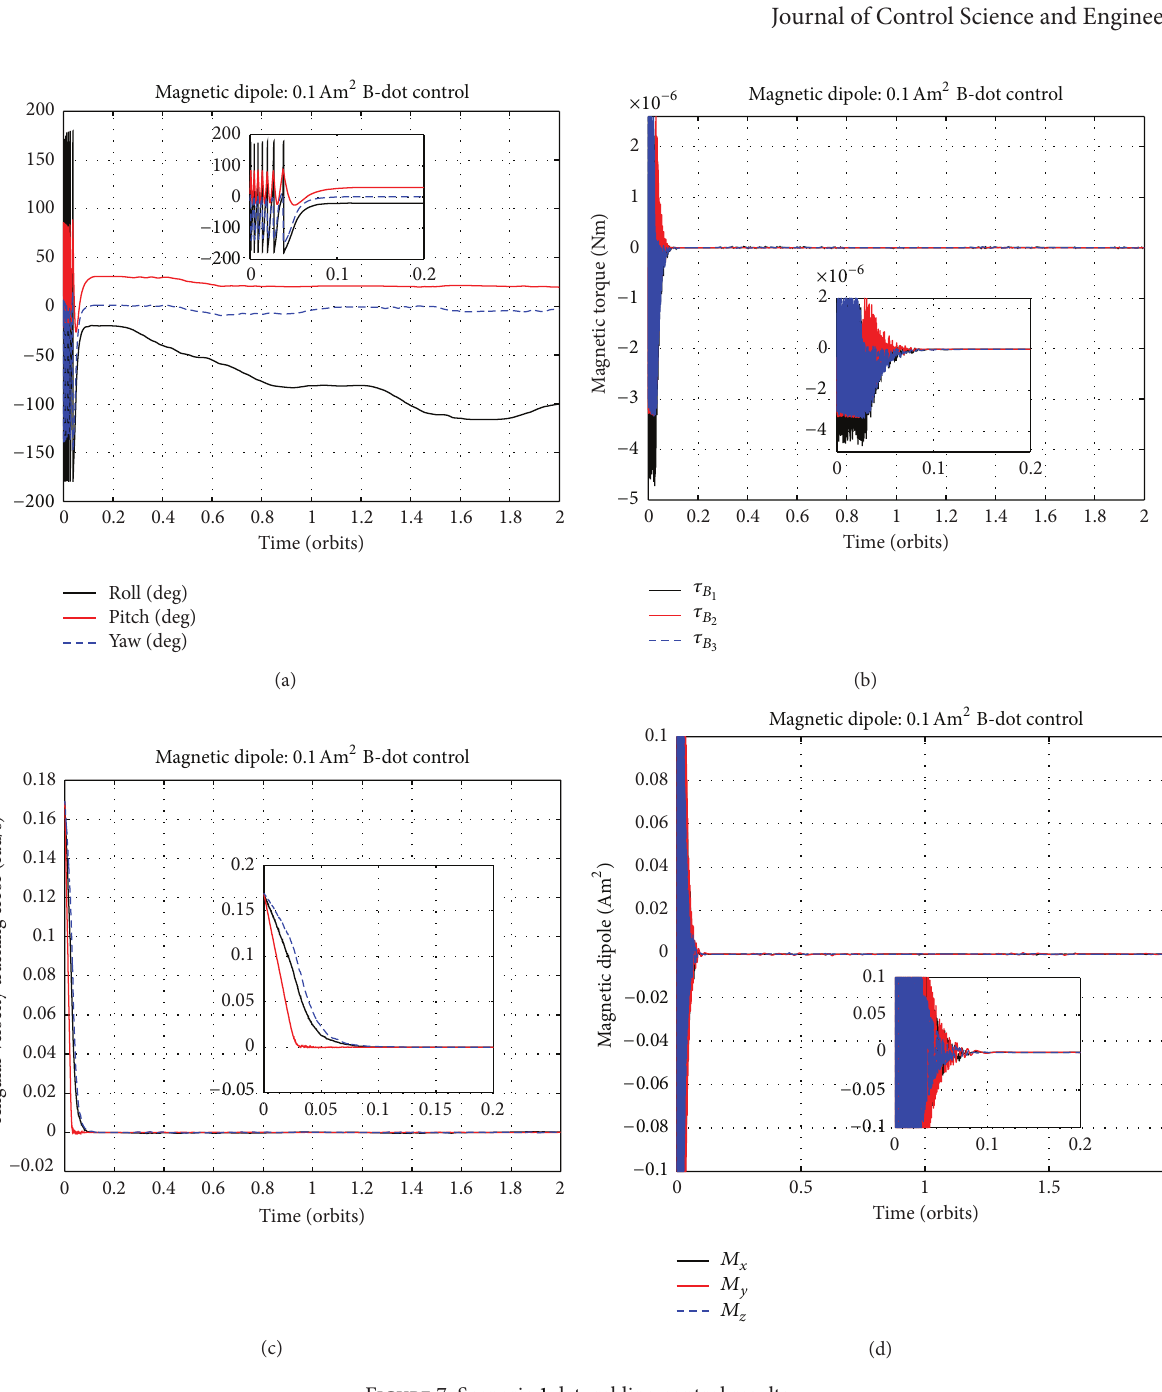
Figure 7: Scenario 1 detumbling control